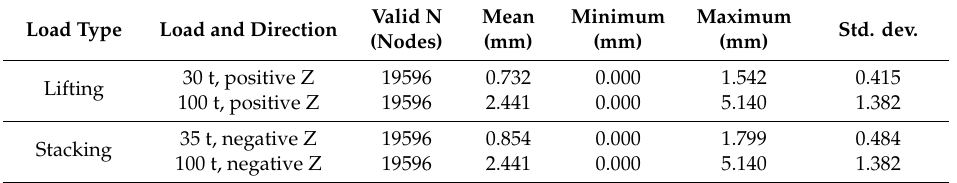
Table 5. Descriptive statistics of total deformations under various loads in the +Z or − Z direction.